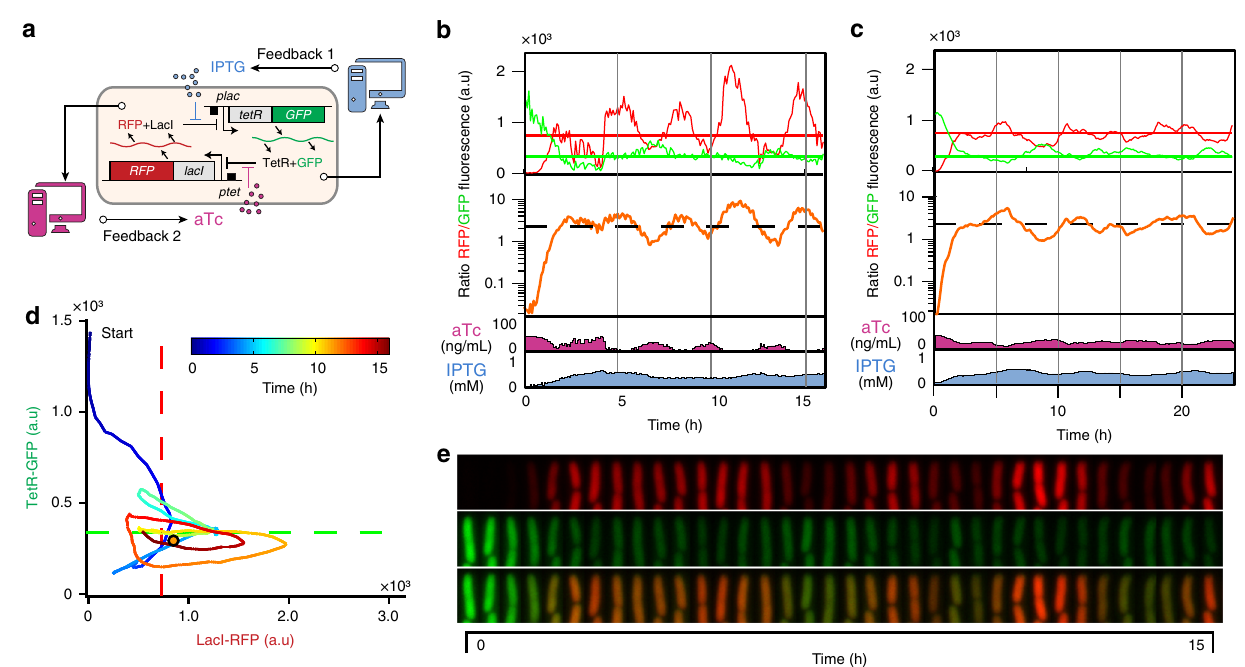
Fig. 2 Cells can be maintained close to the target control point using a dual PI controller. a . A dual controller, in which aTc and IPTG levels were changed independently from one another, was used to reach the respective target levels of RFP and GFP. b . Control experiment in which the dual PI controller is applied to drive an E. coli cell. Temporal evolutions of the red (LacI-RFP) and green (TetR-GFP) fl uorescence levels for the controlled cell are represented (top). The horizontal red and green lines are the target values of both controller branches. The controlled protein levels, although displaying marked oscillations, remains close to their target values. The ratio (orange, middle) of red and green fl uorescence shows that protein expression levels remain comparable over several hours. The concentrations of the inducers applied by the dual PI controller are represented as a function of time (bottom). The ¼ 3 : 310 (cid:3) 2 ; K L ¼ 1 : 3210 (cid:3) 4 s (cid:3) 1 , K T ¼ 1 : 6510 (cid:3) 2 ; K T ¼ 4 : 610 (cid:3) 4 s (cid:3) 1 (see “ Methods ” section). c In silico control parameters of the PI dual controller are K L P I P I experiment in which the dual PI controller is applied to drive a stochastic version of the toggle switch model. The parameters of the PI dual controller are as in ( b ). d Smoothed trajectory of the experimentally controlled cell in the (LacI-RFP, TetR-GFP) state space. The controlled cell remains close to the target control point and at some distance from the attractive states, where LacI or TetR dominate. e . Fluorescence images (RFP, GFP, merge) of cells under remote control shown in d , c (cell size ~ 1 µ m). The controlled cells express comparable levels of both RFP and GFP. See Fig. 3 and Supplementary Fig. 7